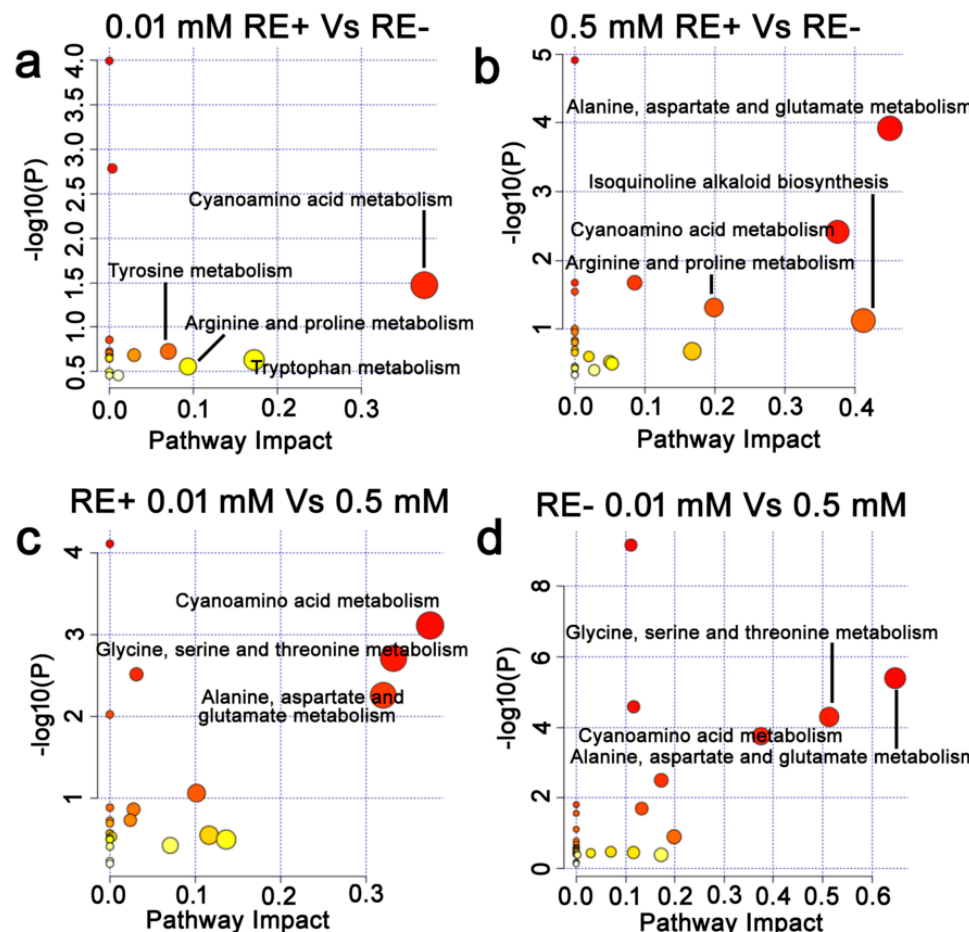
Figure 9. The enrichment analysis of metabolic pathway in roots. The metabolic pathways of a, b, c, and d mean between RE+ and RE − at 0.01 mM P (0.01 mM RE+ vs. RE − ) ( a ); between RE+ and RE − at 0.5 mM P (0.01 mM RE+ vs. RE − ) ( b ); between 0.01 and 0.5 mM P in RE+ (RE+ 0.01 mM vs. 0.5 mM) ( c ); between 0.01 and 0.5 mM P in RE − (RE − 0.01 mM vs. 0.5 mM) ( d ), respectively.